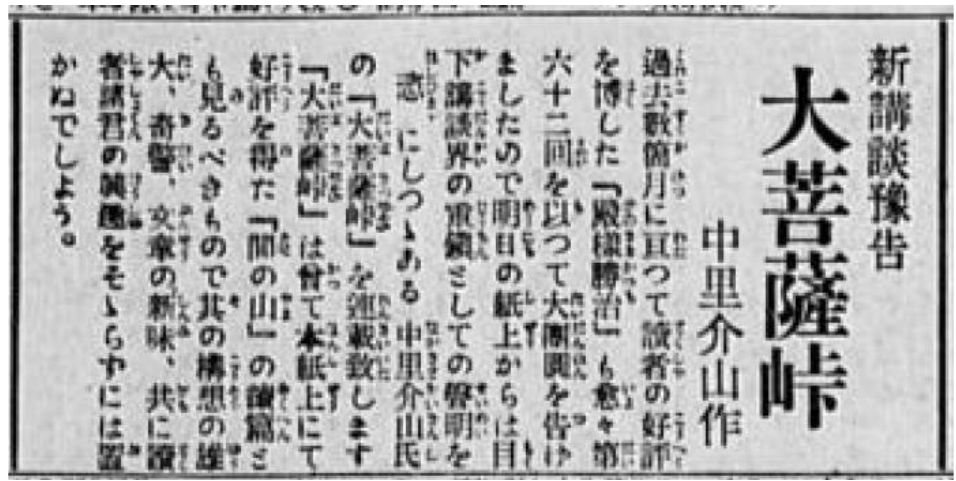
Figure 3. Advertisement for The Great Boddhisattva Pass . Nichibei shinbun 10 April 1925. Image cour- tesy of the Hoji Shinbun Digital Collection.